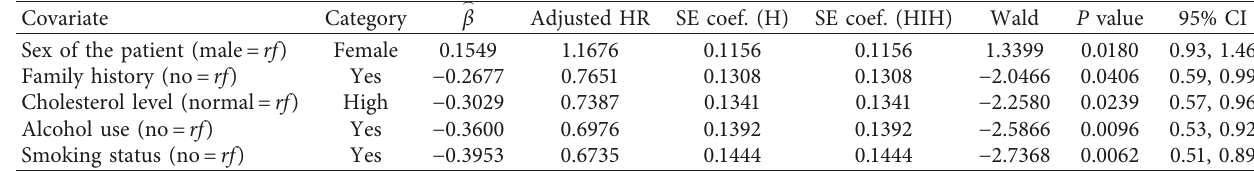
Table 4: Multiple covariate analysis of the shared lognormal frailty